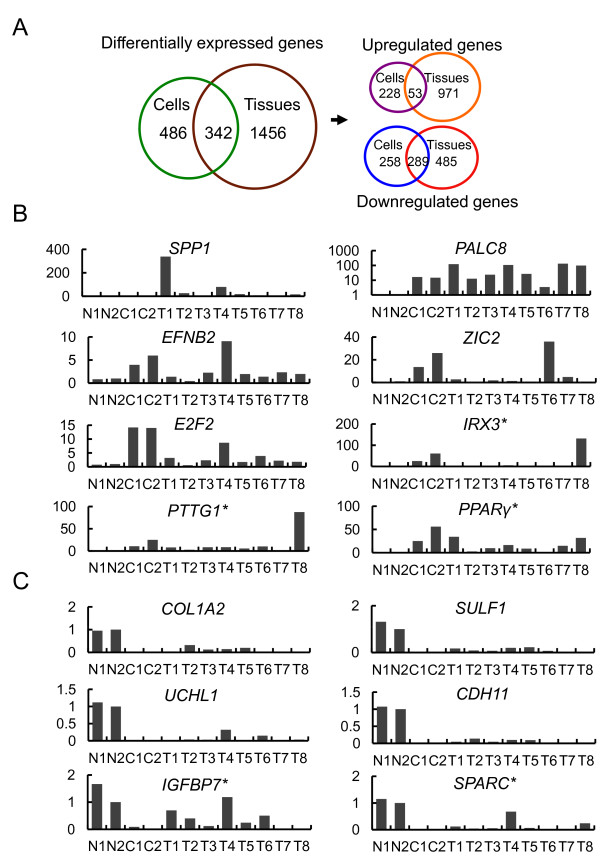
Differentially regulated genes in human CC tissues compared to NBE cells. (A) Venn diagram of genes commonly regulated in the cell and tissue samples. The 342 genes included 53 upregulated and 289 downregulated genes, selected from the cell- and tissue-based microarray databases. (B) Real-time RT-PCR analysis of upregulated genes selected from the list of top 25 genes commonly upregulated in both CC cells (C) and tissues (T) compared to cultured NBE cells (N). *, selected from only the cell-based microarray database. (C) Real-time RT-PCR analysis of downregulated genes selected from the list of top 25 genes commonly downregulated in both CC cells (C) and tissues (T) compared to cultured NBE cells (N). *, selected from only the cell-based microarray database.